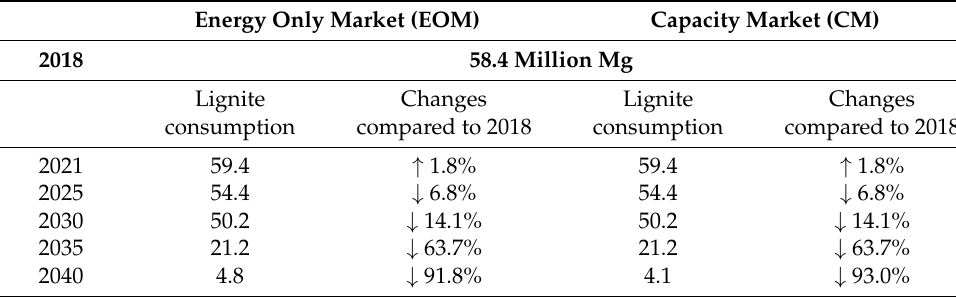
Table 9. Lignite consumption for electricity generation.